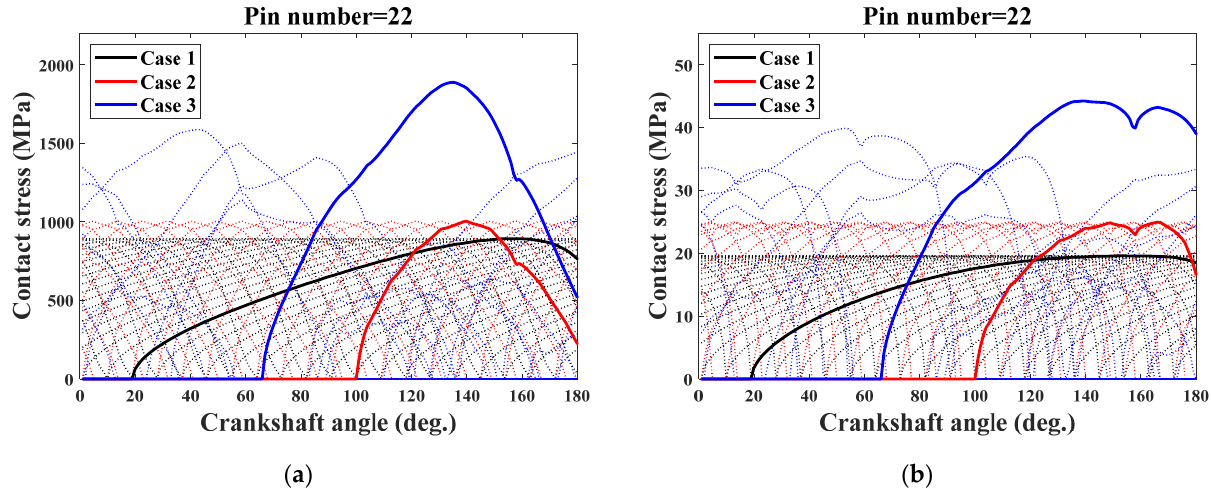
Figure 13. Comparison of the time-varying Hertzian contact stress on all ( a ) the pins and ( b ) the corresponding pin-grooves.